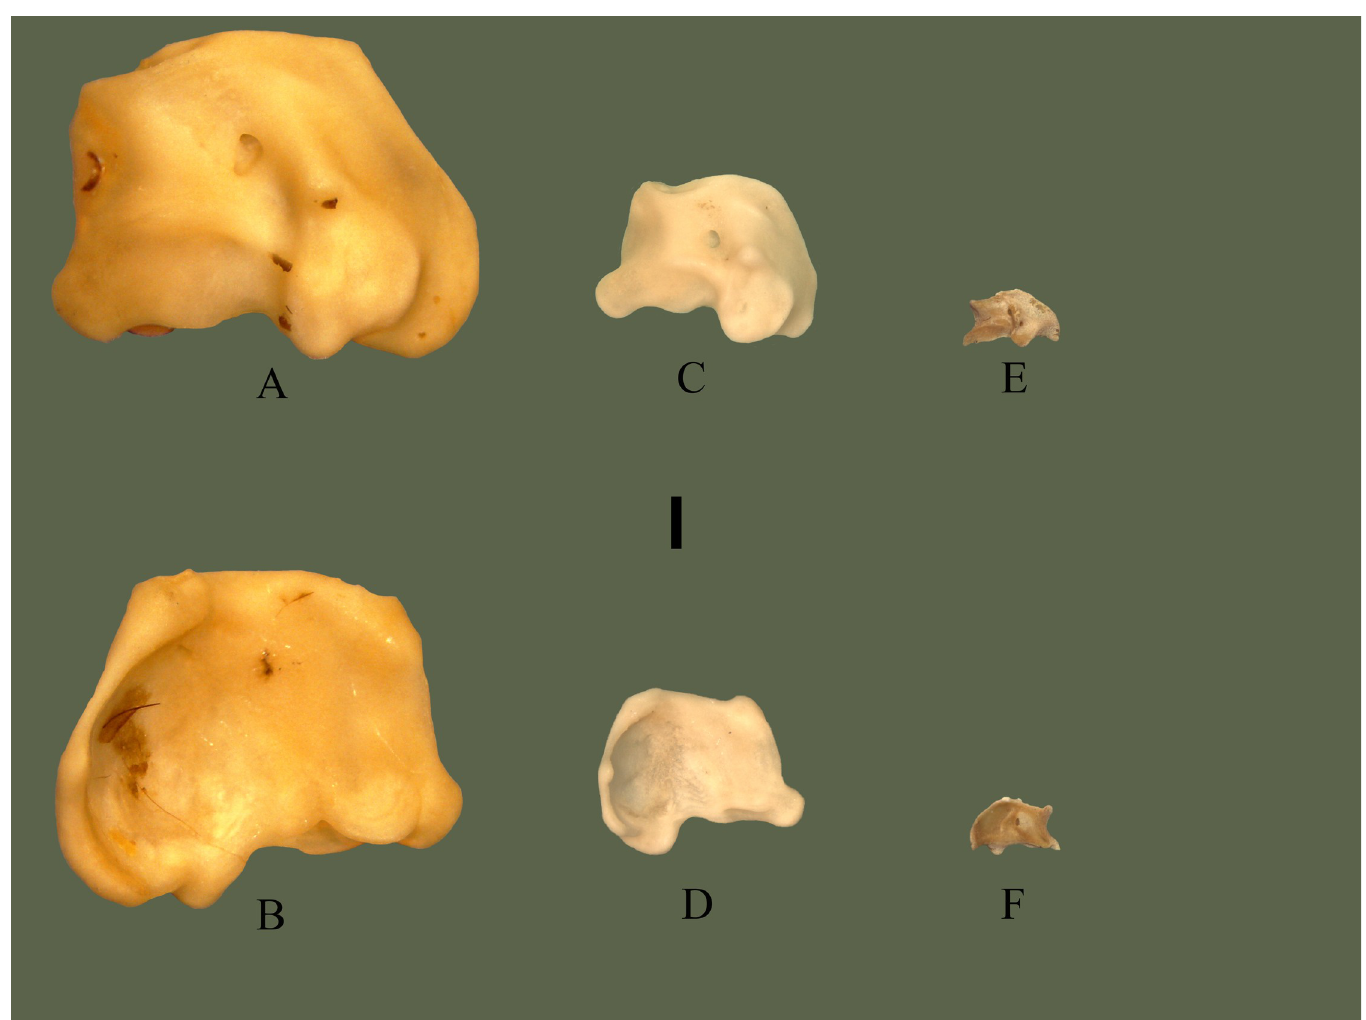
Fig 22. Prefrontal ontogeny. ETVP 3295 in dorsal (A) and ventral (B); ETVP 3293 in dorsal (C) and ventral (D); ETVP 3306 in dorsal (E) and ventral (F). Anterior is to the top of the page. Scale bar = 1